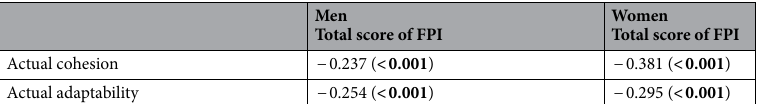
Women Total score of FPI